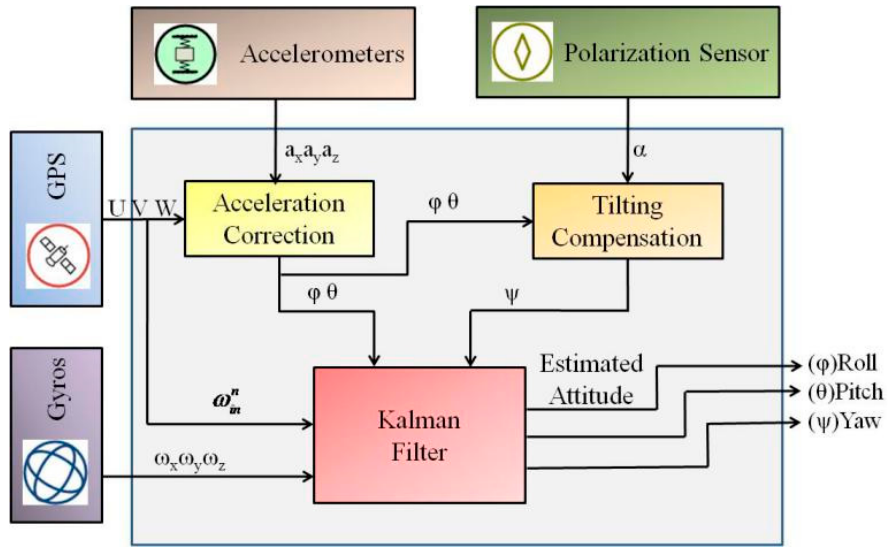
Figure 1. The schematic diagram of proposed algorithm.